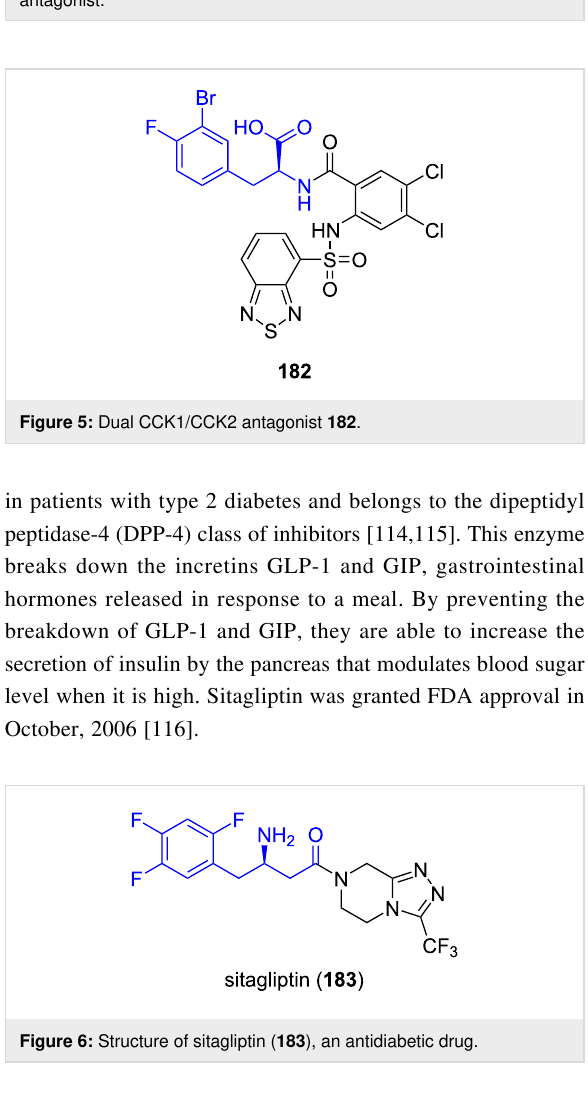
Retagliptin phosphate: Retagliptin phosphate ( 184 ) is under investigation as a DPP-4 inhibitor for treating type-2 diabetes. It